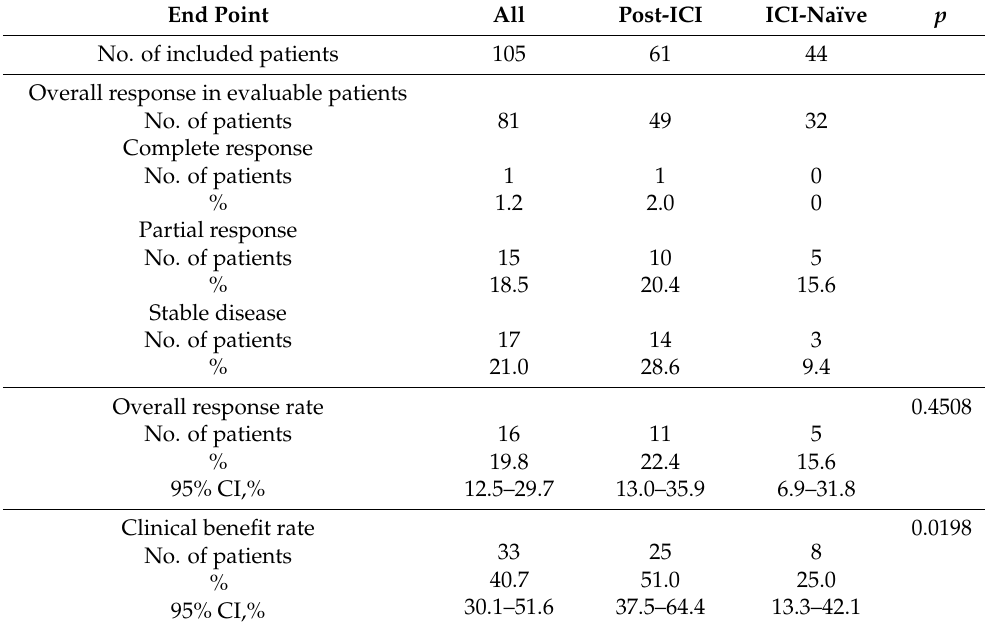
Table 2. Treatment